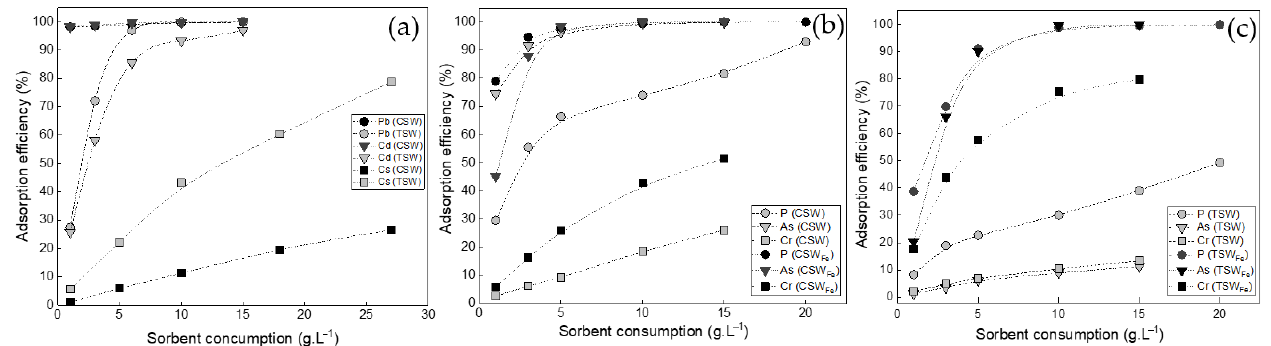
Figure 6. Adsorption efficiency of Pb 2+ , Cd 2+ and Cs + adsorption on CSW and TSW ( a ), AsO 43 − , PO 43 − and CrO 42 − adsorption on CSW and TSW ( b ) and AsO 43 − , PO 43 − and CrO 42 − adsorption on CSW Fe and TSW Fe ( c ). Initial concentration c 0 = 0.5 mmol · L − 1 simulated heavily contaminated waters.